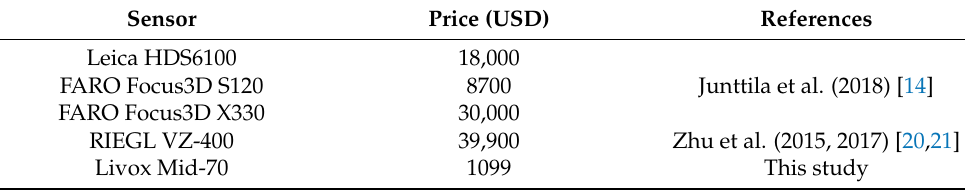
Table 1. A price list of conventional LiDAR and Livox Mid-70 (as of May 2022).